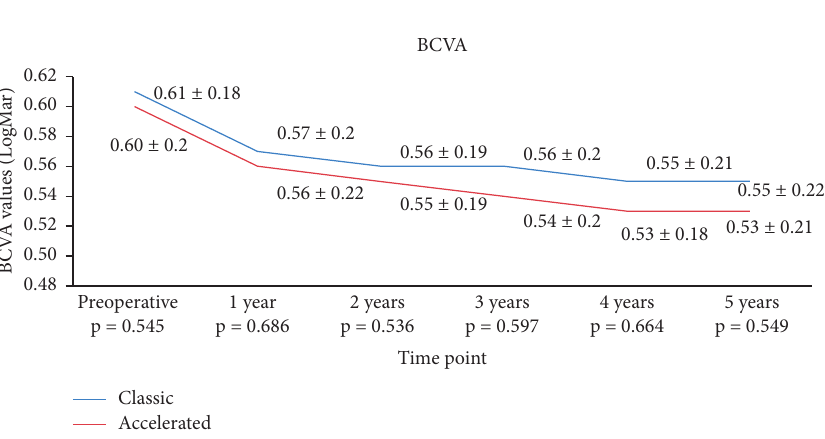
Figure 8: Evolution of BCVA in both